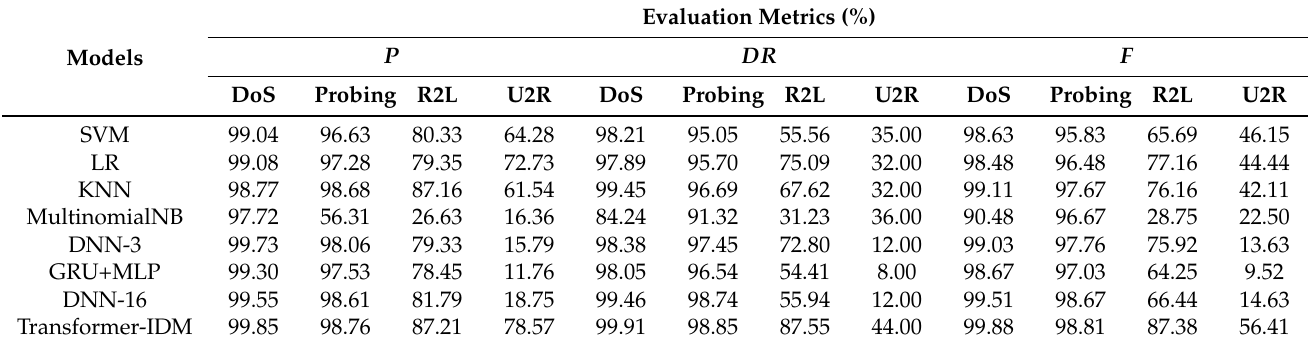
Table 5. The values of evaluation metrics of each attack category for different models.